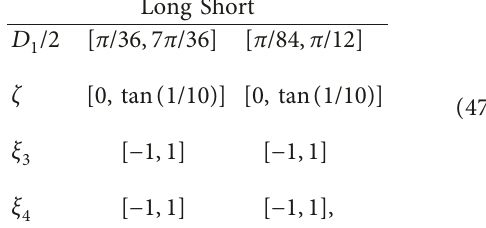
is random, and the cone diameter R 1